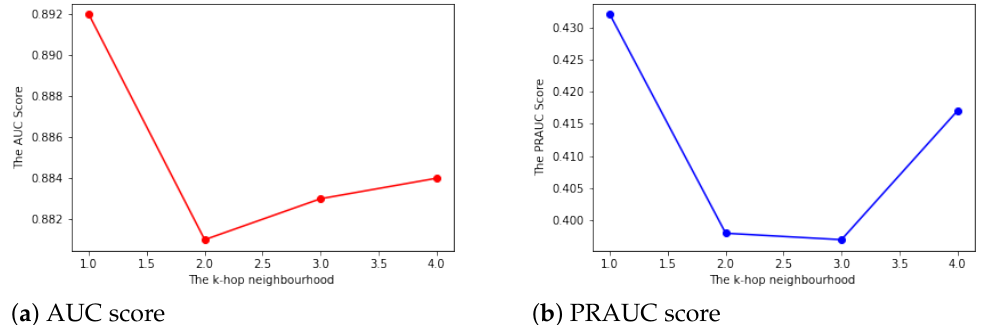
Figure 5. The evaluation metrics with different K values. In ( a , b ), we use the window size l = 10 and the penalty value for nonexisting links are 4. We set the K -hop neighborhood for the GCN units from 1 to 4, and the performance of AUC and PRAUC scores are shown in ( a , b